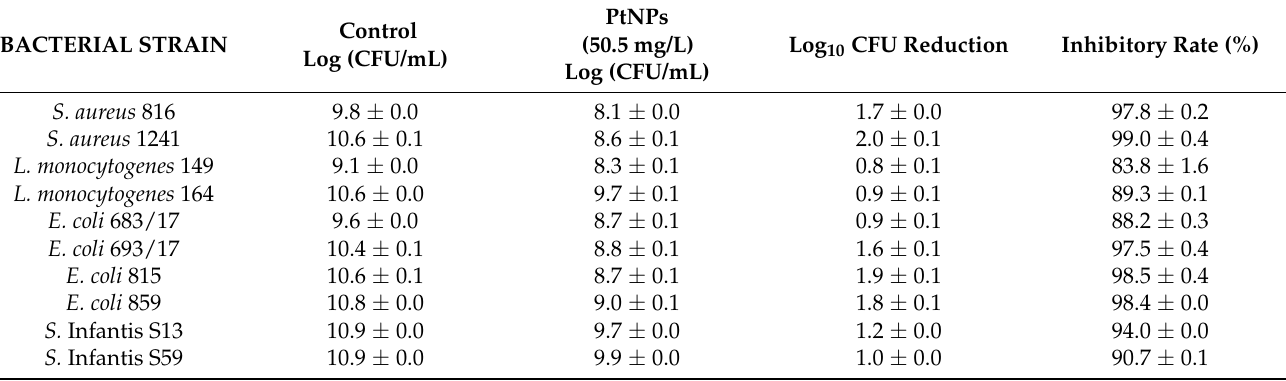
Table 6. Reduction in viable colony counts caused by 24 h exposure to PtNPs (50.5 mg/L). Data represent the mean of at least four independent